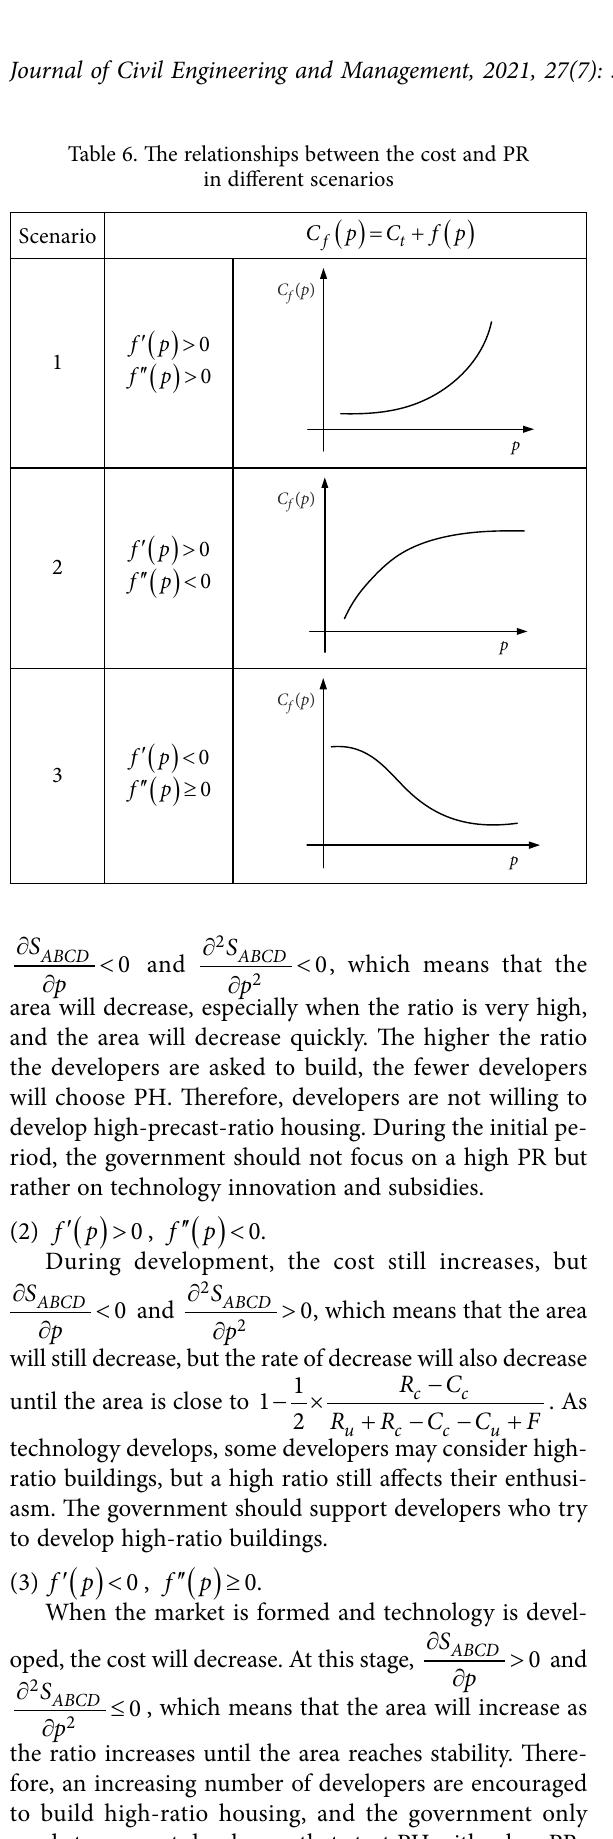
Figure 13. The vicious circle of the cost and